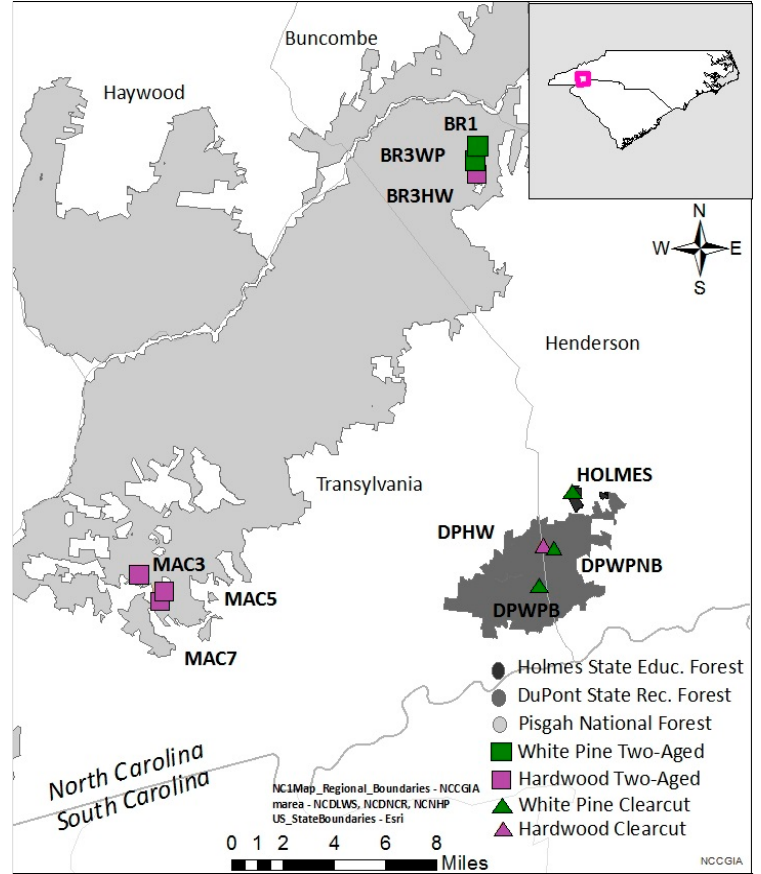
Figure 1. Map of sites in western North Carolina sampled using pitfall traps from July to August of 2016 and June to August of 2017. MAC3, MAC5, MAC7, BR3HW, BR3WP, and BR1 were located in Pisgah National Forest. DPWPNB, DPWPB, and DPHW were located in DuPont State Recreational Forest. HOLMES was located in Holmes Educational State